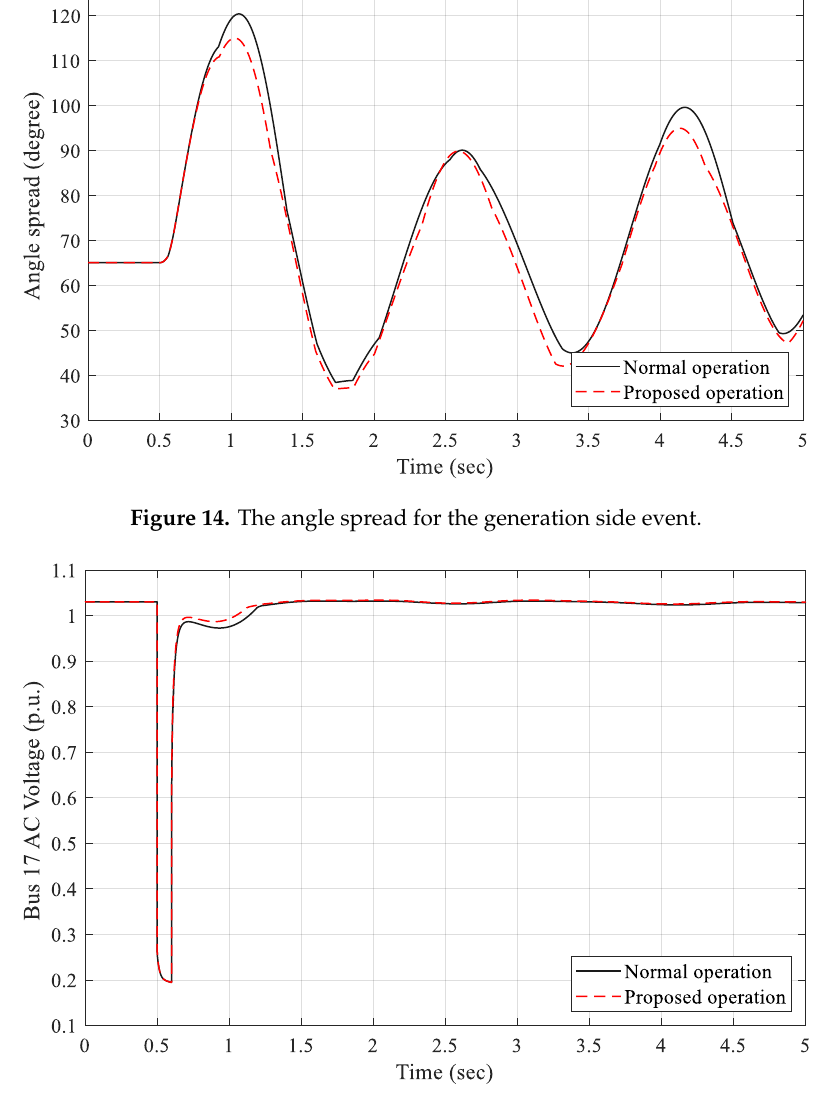
Figure 15. The AC voltage of the inverter station for the generation side event.